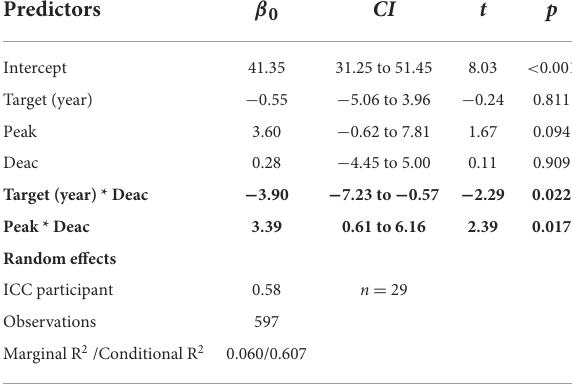
TABLE 3 Results of multinomial logistic regression analysis. B